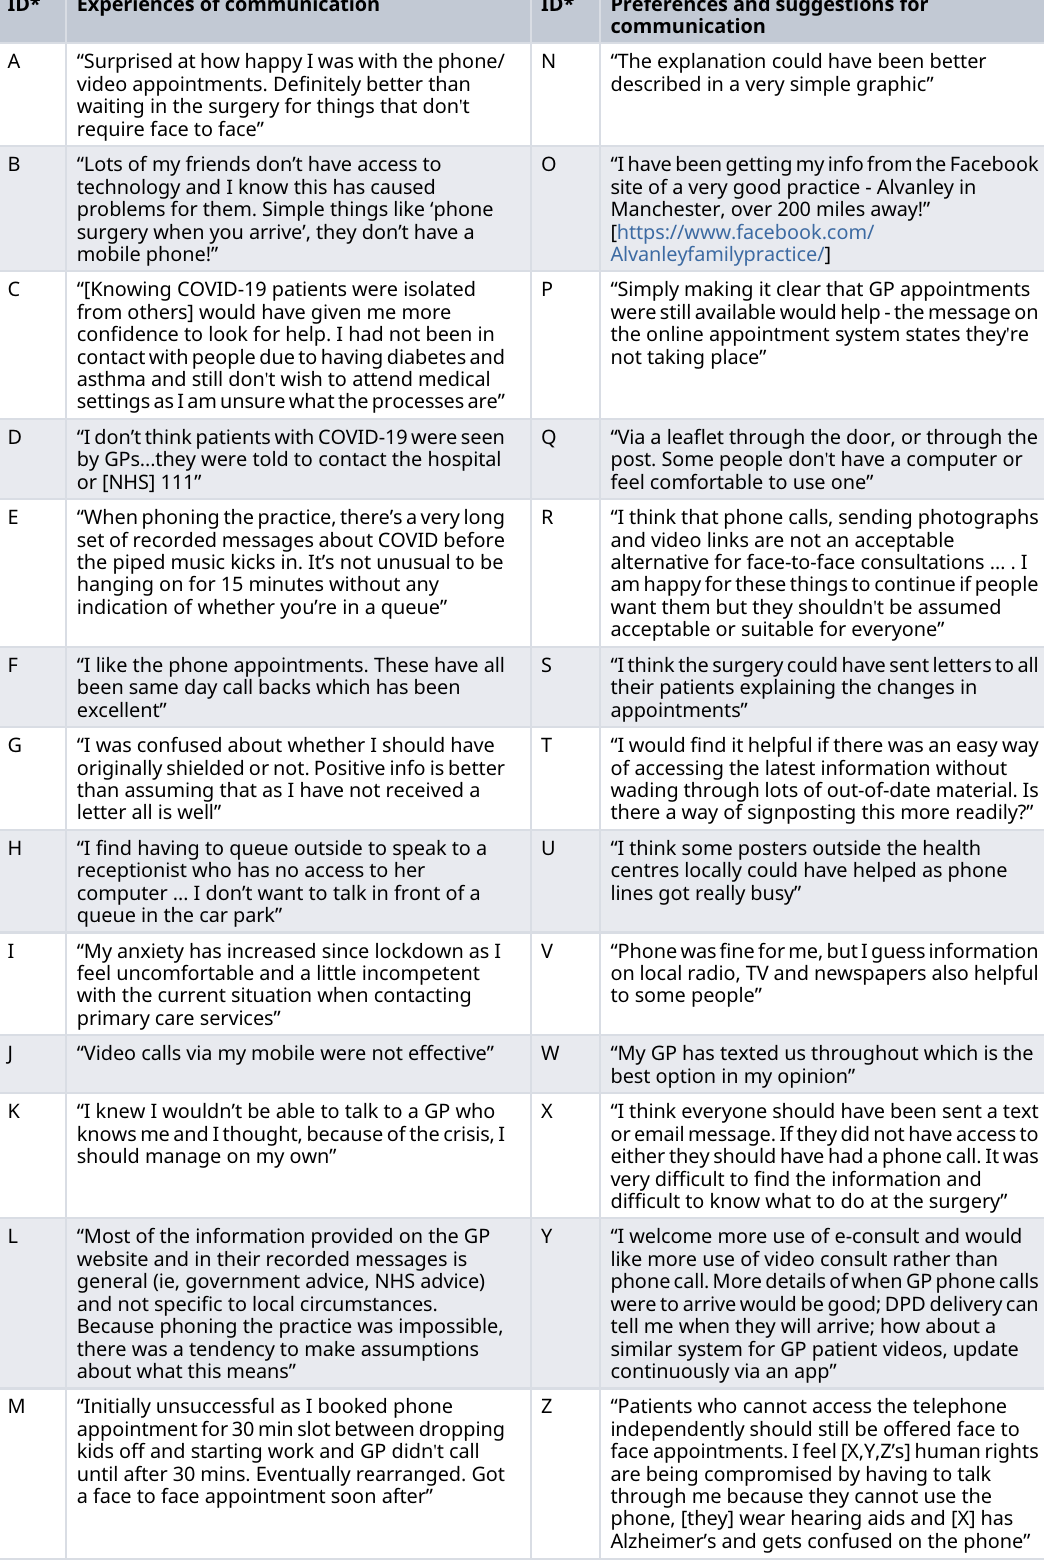
Table 2. Selected perspectives of respondents on their communication with general practice, March to September 2020. Quotations were selected to demonstrate themes across responses rather than to represent levels of satisfaction. *Each quotation has been assigned an identifier (A-Z) for referencing within the text.